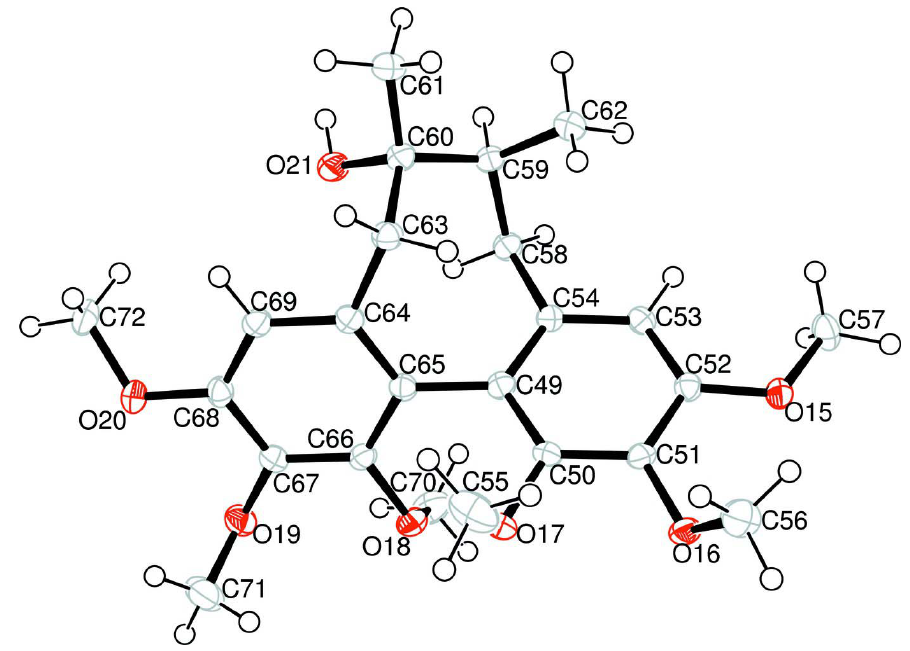
View of the third molecule in the asymmetric unit with the atom-numbering scheme and 50% probability displacement